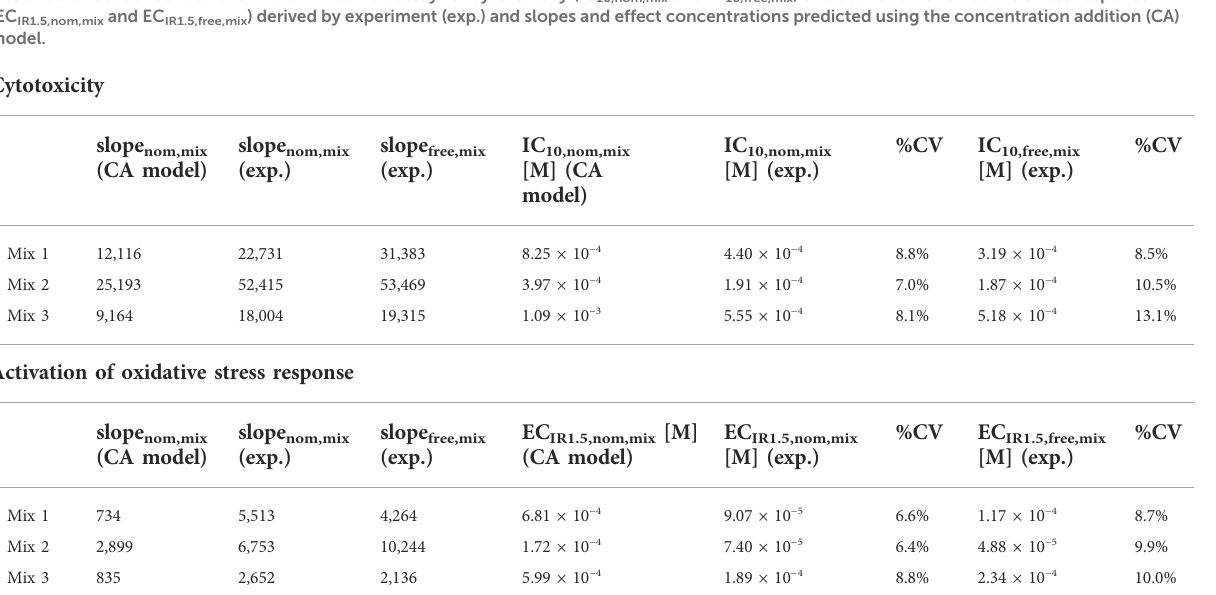
TABLE 2 Slopes of the nominal (slope nom,mix ) and freely dissolved concentration response curves (slope free,mix ) of the mixtures, nominal and freely dissolved effect concentrations in the AREc32 bioassay for cytotoxicity (IC 10,nom,mix and IC 10,free,mix ) and activation of oxidative stress response (EC IR1.5,nom,mix and EC IR1.5,free,mix ) derived by experiment (exp.) and slopes and effect concentrations predicted using the concentration addition (CA) model.